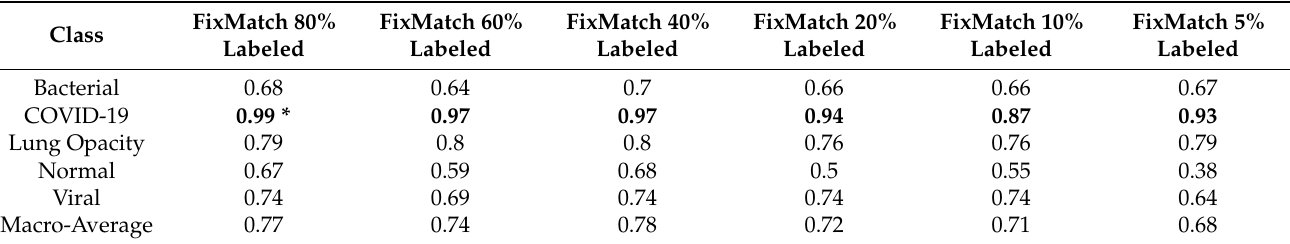
Table 7. Class-wise F1-score of